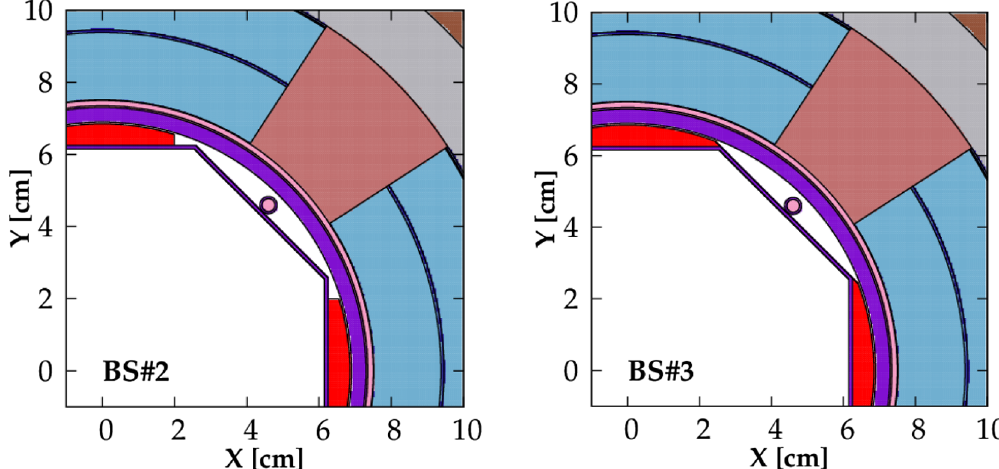
FIG. 12. Left: Beam screen model as per the first conceptual design (BS#2) [24]. Right: Beam screen model with the modification of the absorbers driven by energy deposition considerations (BS#3).